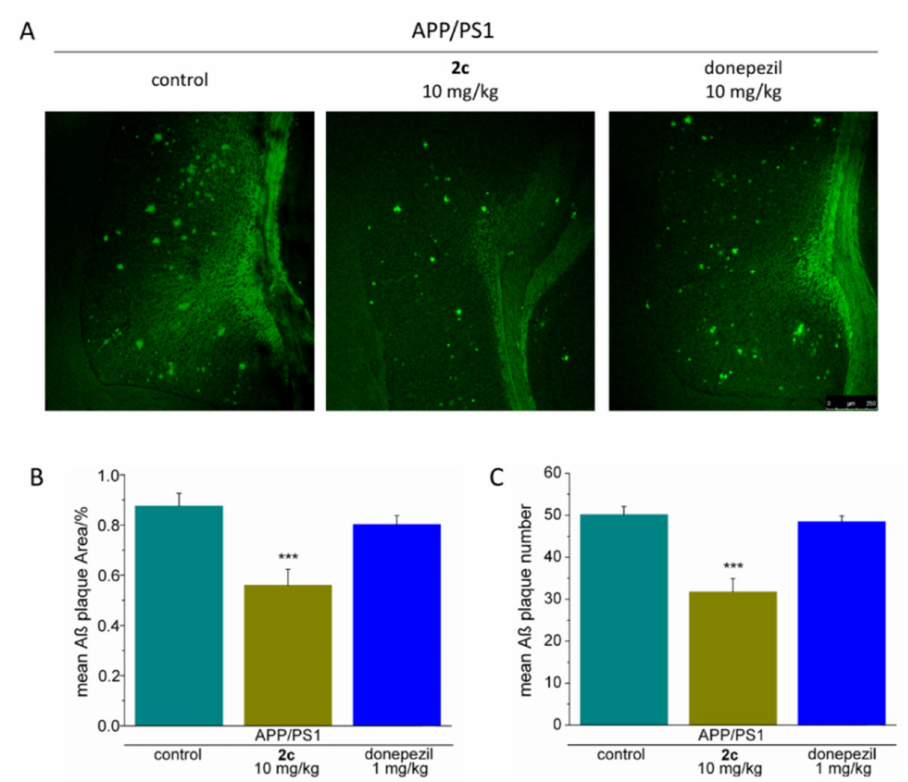
Figure 8. Effect of compound 2c and donepezil on number of A β plaques in the cross-sections of APP/PS1 mice entorhinal cortex. ( A ) Representative images indicating A β plaques in the entorhinal cortex of control APP/PS1 mice and APP/PS1 mice treated with compound 2c or donepezil for 18 days. The scale bar is 250 µ m. ( B ) Mean number of thioflavin S fluorescent spots in cross-sections of APP/PS1 mice entorhinal cortex. ( C ) Mean area of thioflavin S fluorescent spots in cross-sections of APP/PS1 mice entorhinal cortex. Data are reported as mean ± SE. Statistical analysis was performed using the Mann–Whitney test. *** p < 0.05 compared to control